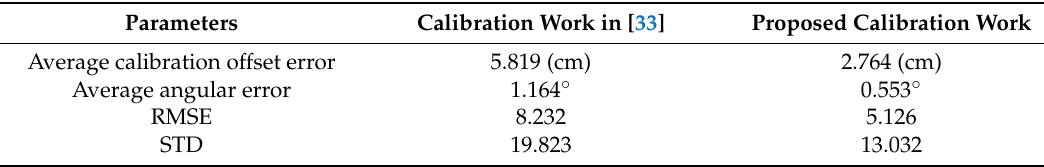
Table 1. Analysis result of multi-sensor joint